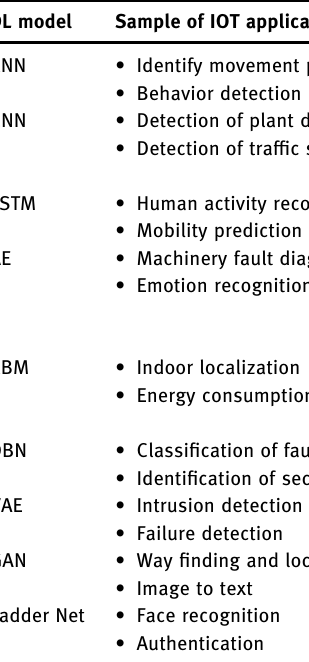
Table 3: Examples of deep learning models and IOT samples [ 71 ]